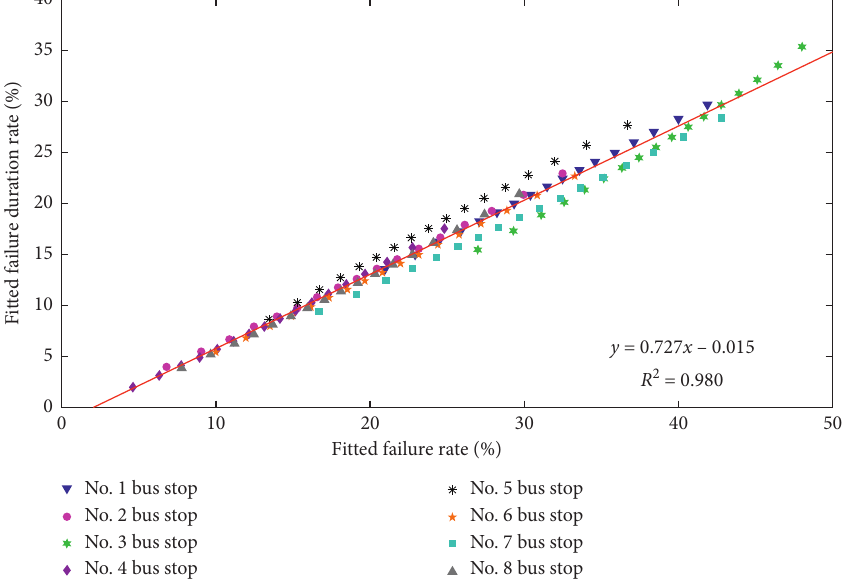
Figure 12: Gen. Extreme Value distribution fitted FDR vs. FR correlation analysis.